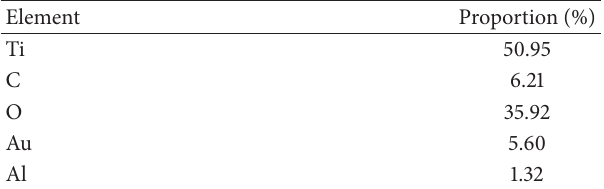
Table 3: Nanotitanium, EDX analysis of element